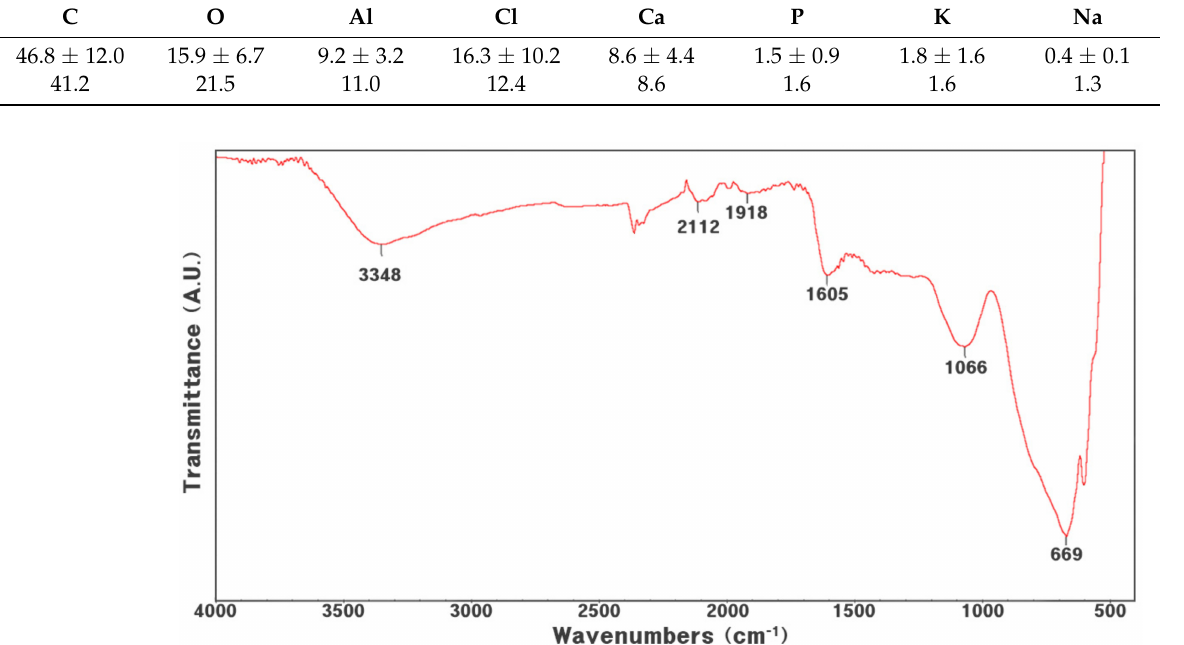
Figure 3. Fourier transform infrared spectroscopy spectra of Al-FWB.